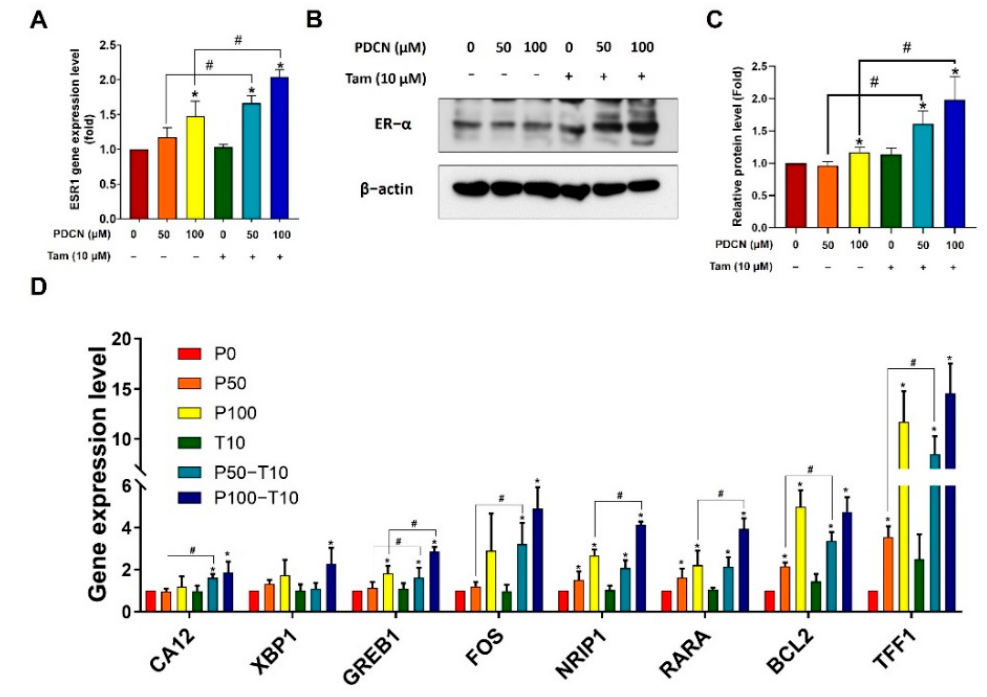
Figure 7. Pentadecanoic acid induces ER − α expression in MCF/7/SC cells . ( A ) Gene expression of ER − α after pentadecanoic acid treatment alone or in combination with 10 µ M tamoxifen. ( B , C ) The protein level of ER − α was determined after pentadecanoic acid treatment alone or in combination with 10 µ M tamoxifen by Western blot analysis in MCF/7/SC cells. ( D ) The expression of ER − α − related genes after 48 − h treatment with pentadecanoic acid alone or in combination with 10 µ M tamoxifen in MCF − 7/SC cells. β − actin was used as a loading control. PDCN: pentade- canoic acid; Tam: tamoxifen. P0, P50, or P100: the doses of pentadecanoic acid at 0 µ M, 50 µ M, or 100 µ M. T10: the dose of tamoxifen at 10 µ M. The asterisk (*) indicates p < 0.05 vs. the control. The hash mark (#) indicates p < 0.05 when comparing the combined vs. individual treatments. Data are representative of three biologically independent experiments and values are shown in mean ±